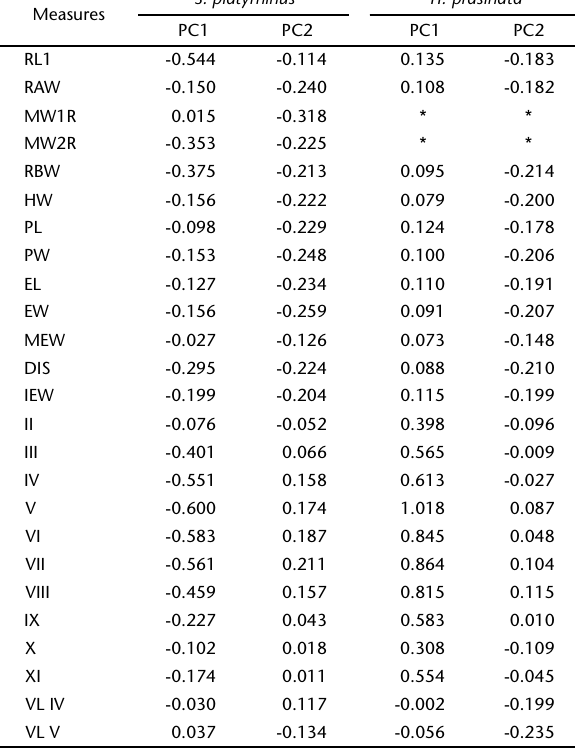
Table V. Loadings of the morphometric variables in the first two components of the Principal Components Analysis (PCA). Variables not measured marked with an